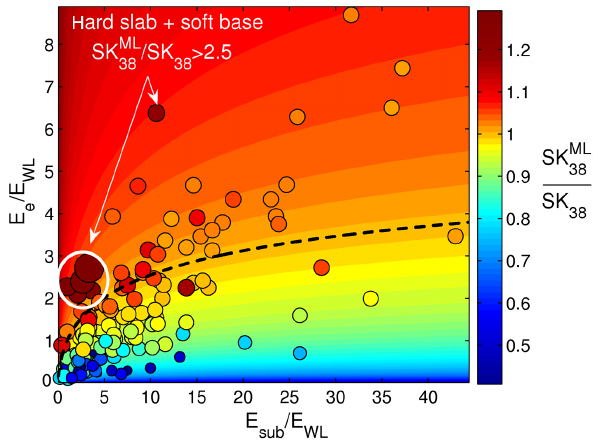
/ SK 38 as a function of E e /E Figure 9. Scatter plot of SK ML and 38 WL E sub /E . The colour and size of the dots relates to the ratio be- WL tween SK ML and SK 38 . The contour plot represents average values 38 (representative of the data set) of slab depth ( (cid:104) h tot (cid:105)= 0.76m) weak (cid:105)= 0.0147m), weak layer Young’s modulus layer thickness ( (cid:104) h WL (cid:105)= 1.5MPa). Arrows point to the few cases for which the ( (cid:104) E WL / SK 38 > 2.5). The dashed bridging effect was substantial (SK ML 38 / SK 38 = line corresponds to SK ML 38